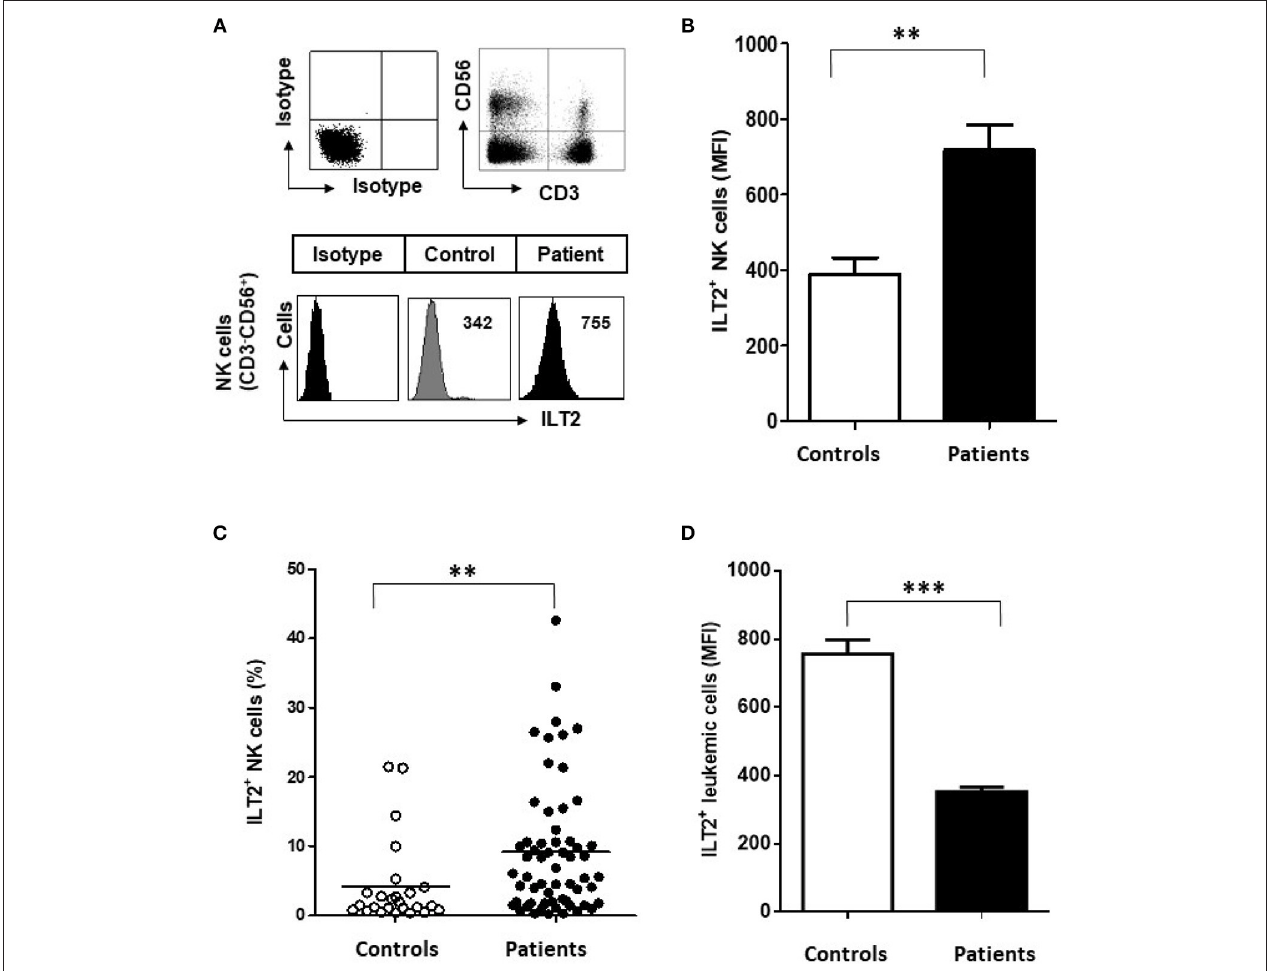
FIGURE 1 | Surface ILT2 expression is increased on NK cells of CLL patients. (A) The expression of ILT2 was analyzed in PBMCs from 60 CLL patients and 25 healthy donors by flow cytometry. The histogram shows the ILT2 expression on NK cells (CD3 − CD56 + ) from a representative healthy donor and a patient with CLL. (B) The comparison between the MFI ± SEM of ILT2 surface expression on NK cells from healthy controls ( n = 25) and patients with CLL ( n = 60) is shown. (C) The comparison between the percentage of ILT2 + NK cells from healthy controls and patients is shown. Horizontal bars represent the mean ± SEM. (D) The comparison between the MFI ± SEM of ILT2 surface expression on leukemic cells and B cells from healthy controls is shown. SEM, Standard Error of the Mean; Mann-Whitney U -test; ** P < 0.01, *** P <